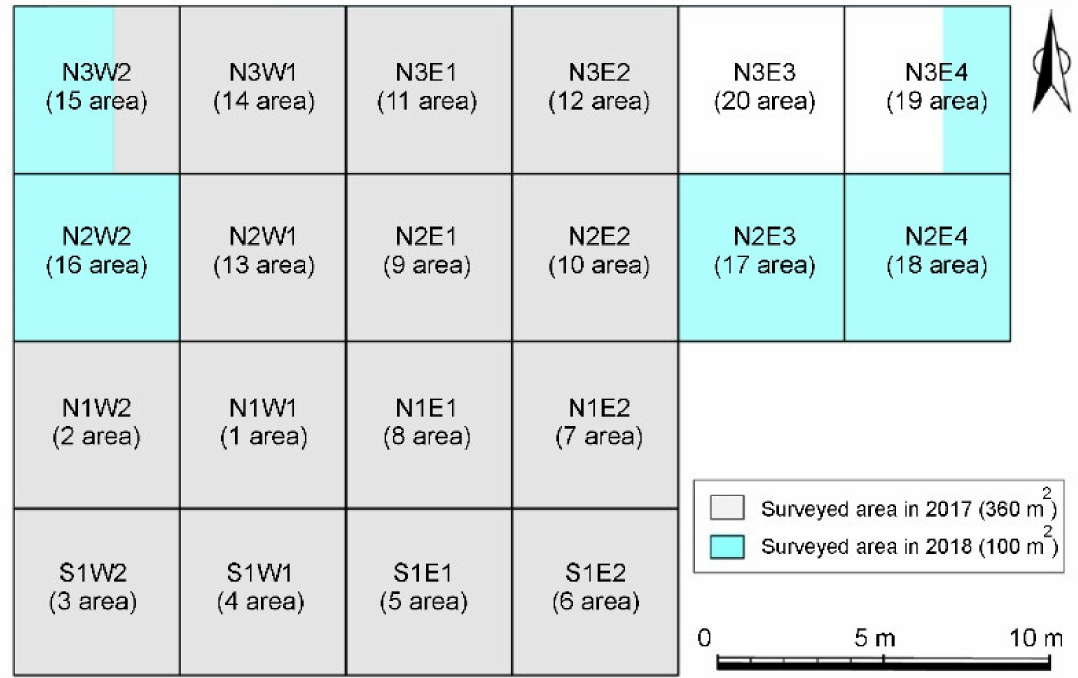
Figure 5. Sediment removal area of the second underwater excavation at the Dangampo